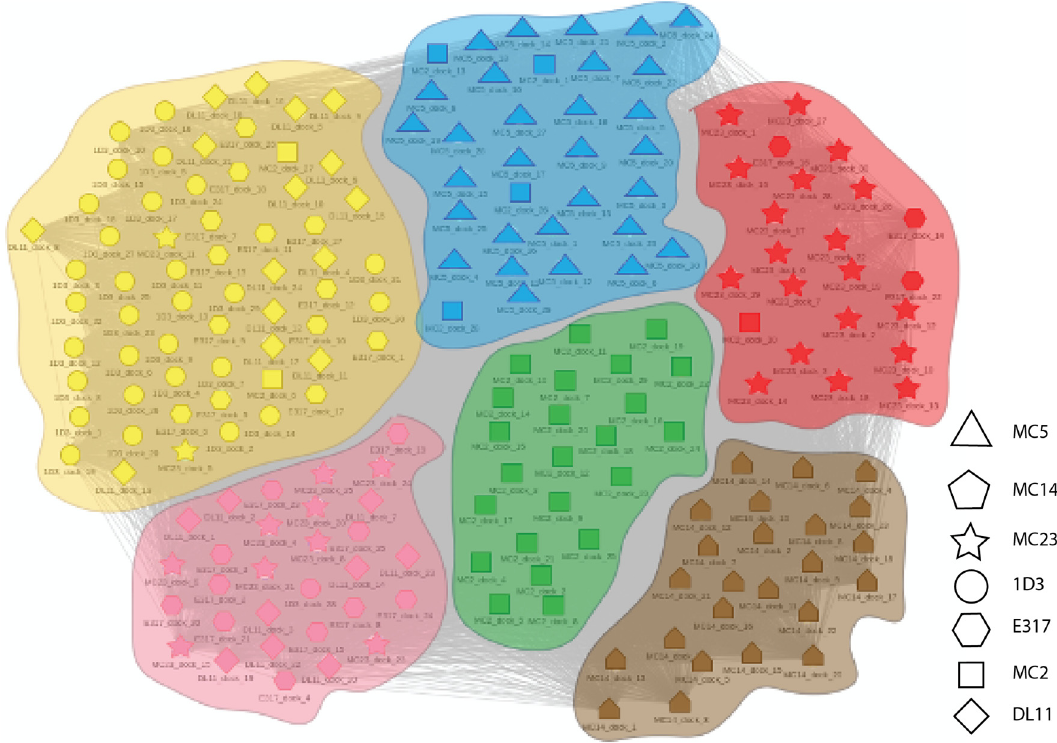
Figure 9. Community map of experimentally-focused docking models for Abs vs. gD2. The same representation as Figure 5, but based on docking models that were focused according to experimental data. Note the relative homogeneity of Abs (different symbols) within each community, contrasting with Figure 5. The shape of each marker indicates the antibody in the dock (i.e., each shape is a single antibody).